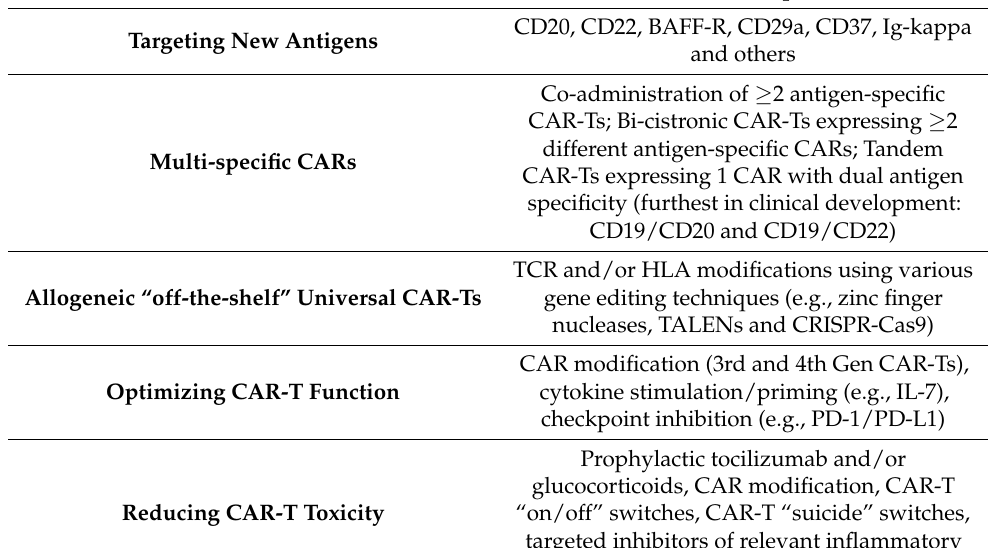
Table 2. Summary table of promising future directions of translational and clinical CAR-T develop- ment. Abbreviations: TALENs: transcription activator-like effector nucleases; CAR: chimeric antigen receptor; Gen: generation; PD-1: programmed cell death protein 1; PD-L1: programmed cell